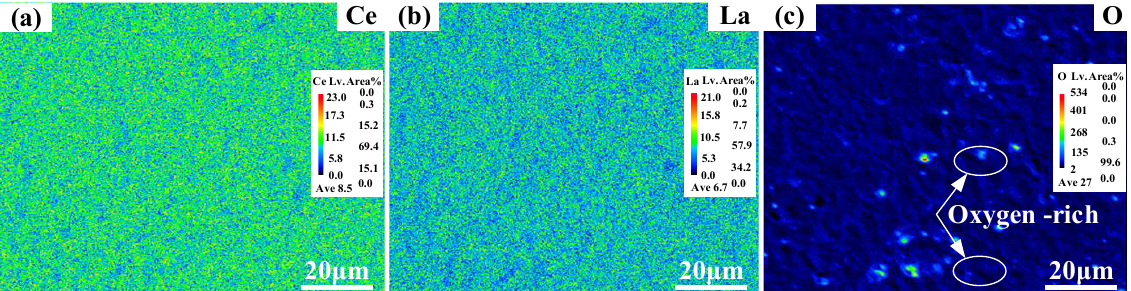
Figure 10. Element distribution and phase analysis of the cladding layer. ( a ) Distribution of Ce; ( b ) Distribution of La; ( c ) Distribution of O.